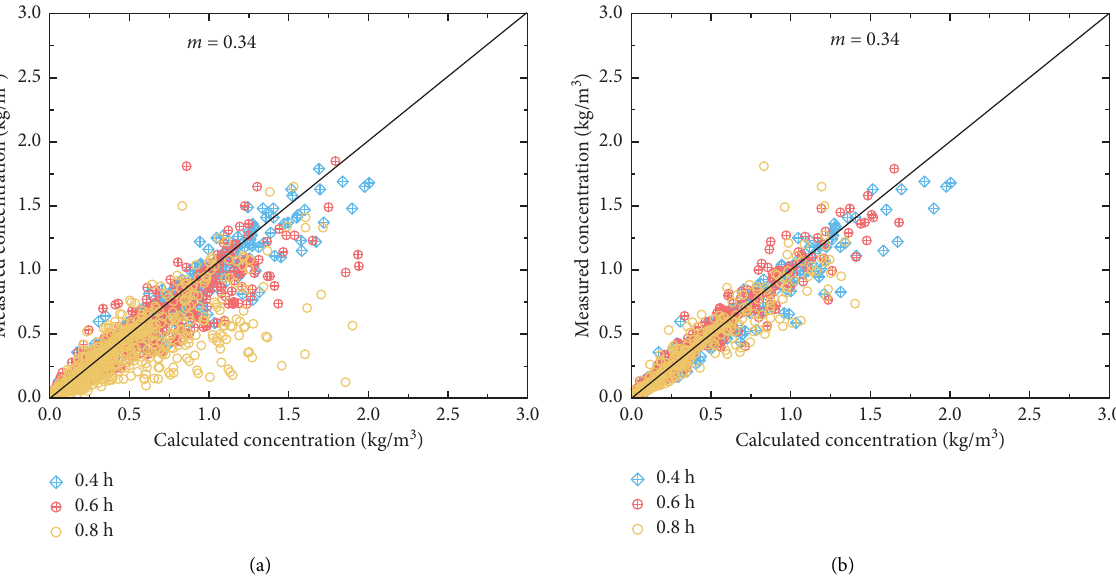
Figure 5: Validation of sediment concentration using the regression coefcient m . Among them, (a) the sediment concentration verifcation with 2100 groups of training data and (b) the calculation accuracy of sediment content with 900 groups of test data.